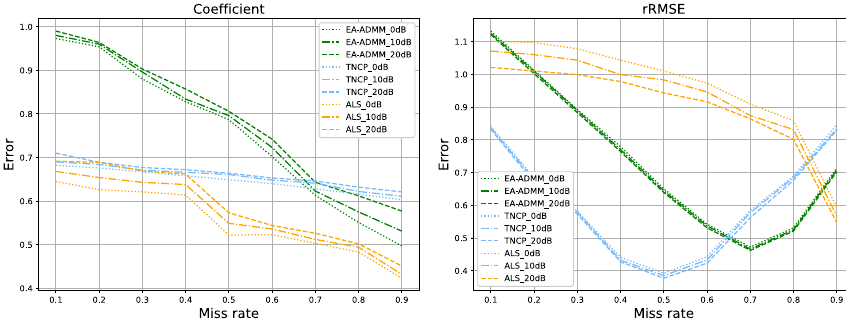
Fig. 7 Tensor completion performance when the missing rate varies from 0.1 to 0.9 and ˆ µ �=